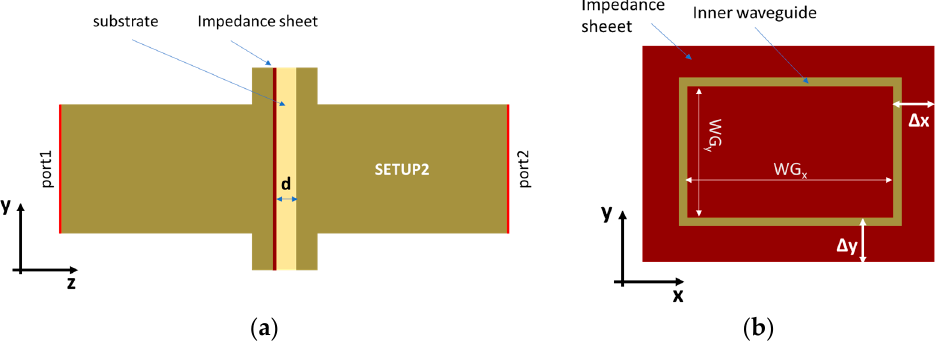
Figure 20. Measurement setup simulated with Ansys Electronics v. 16: ( a ) side view; ( b ) front view.